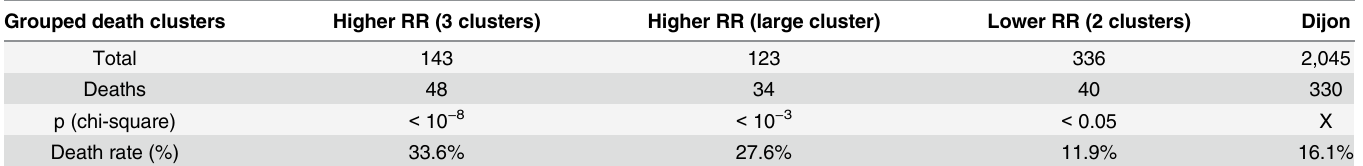
Table 3. Deaths in the mortality-based clusters in 1400.